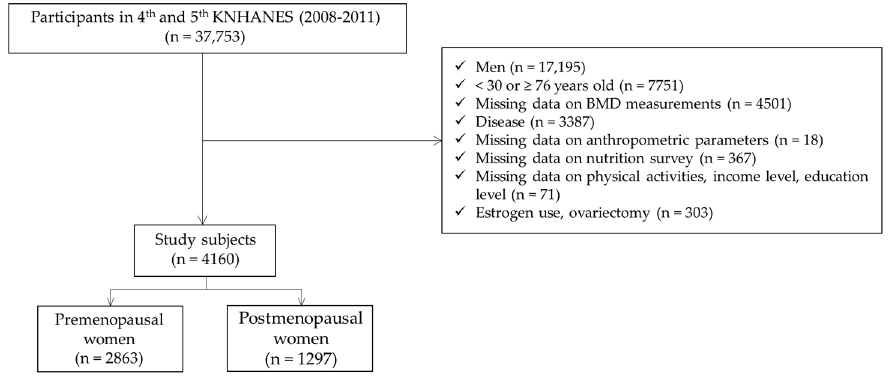
Figure 1. A flow diagram of the study’s inclusion and exclusion criteria of the subjects.